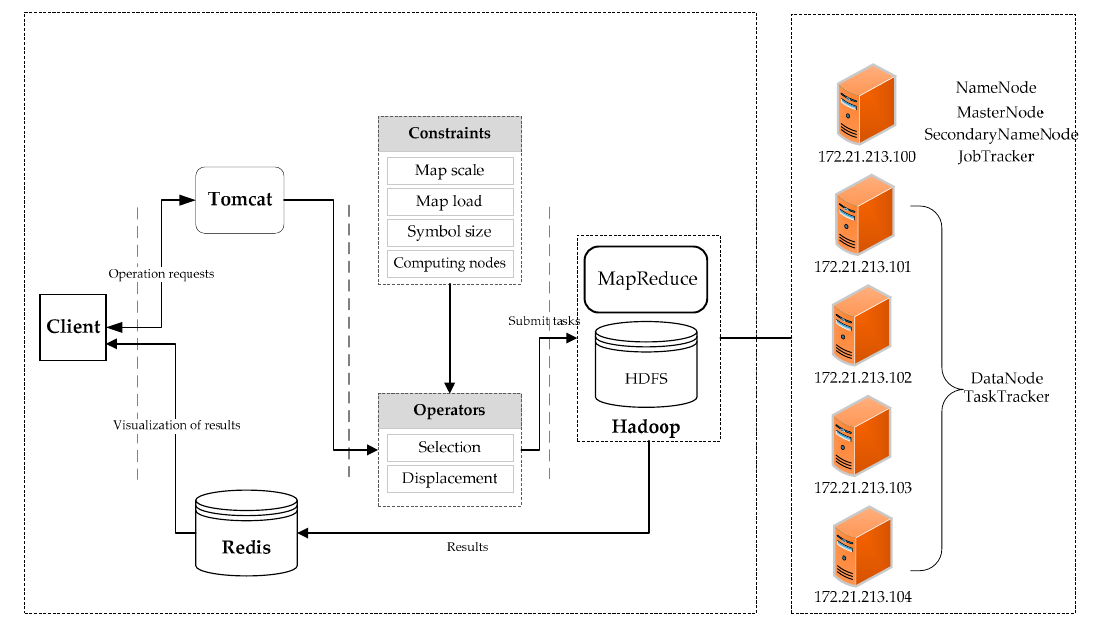
Figure 5. The framework for the point generalization prototype system based on the Hadoop cloud platform.